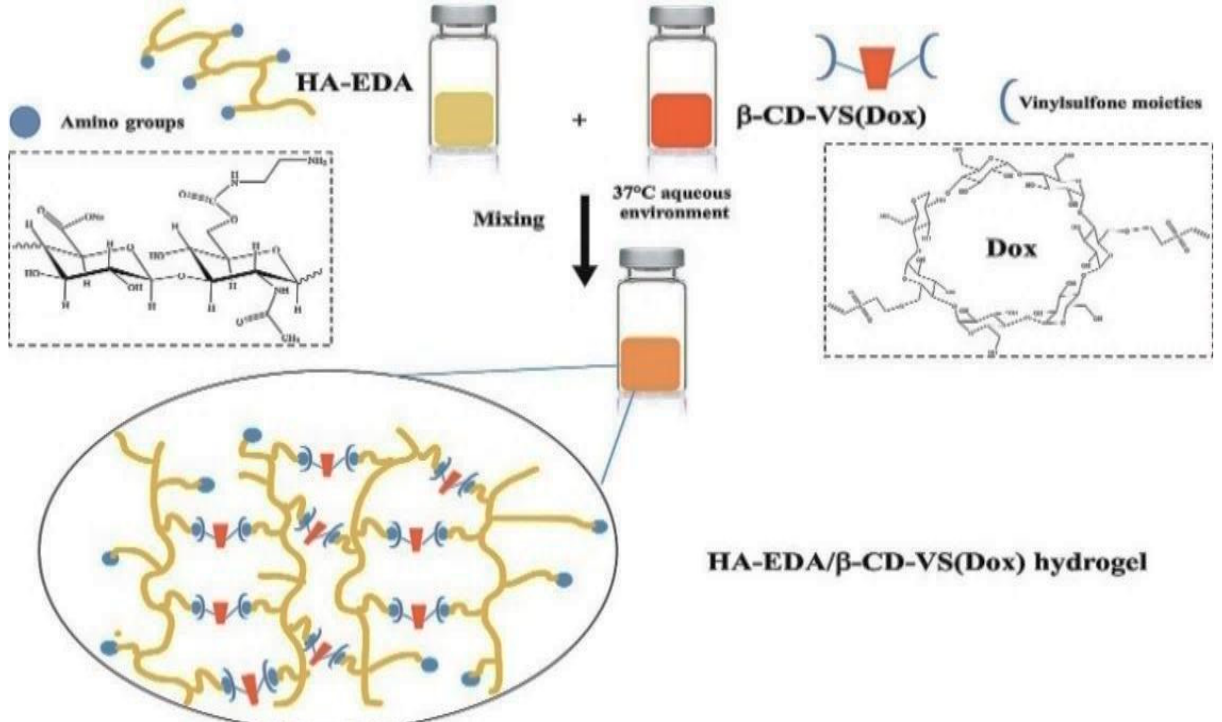
Figure 9. Schematic representation for the preparation of injectable hydrogel via azo-type Michael reaction between HA-EDA and β -CD-VS(Dox) (adapted with permission from Fiorica et al., 2021).